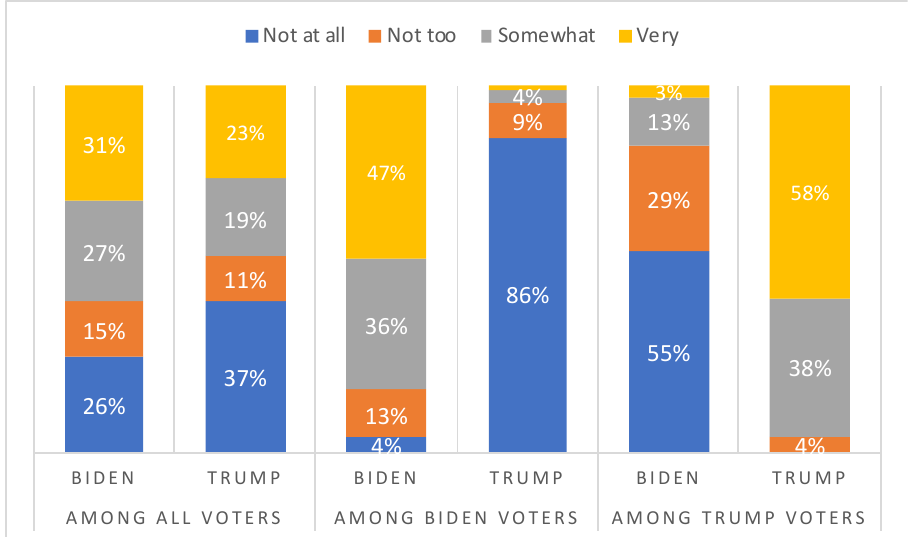
Figure 7. Trust in the candidates’ ability to manage the COVID-19 health crisis. Source: Own elaboration from Pew Research’s American Trend Panel (2020).